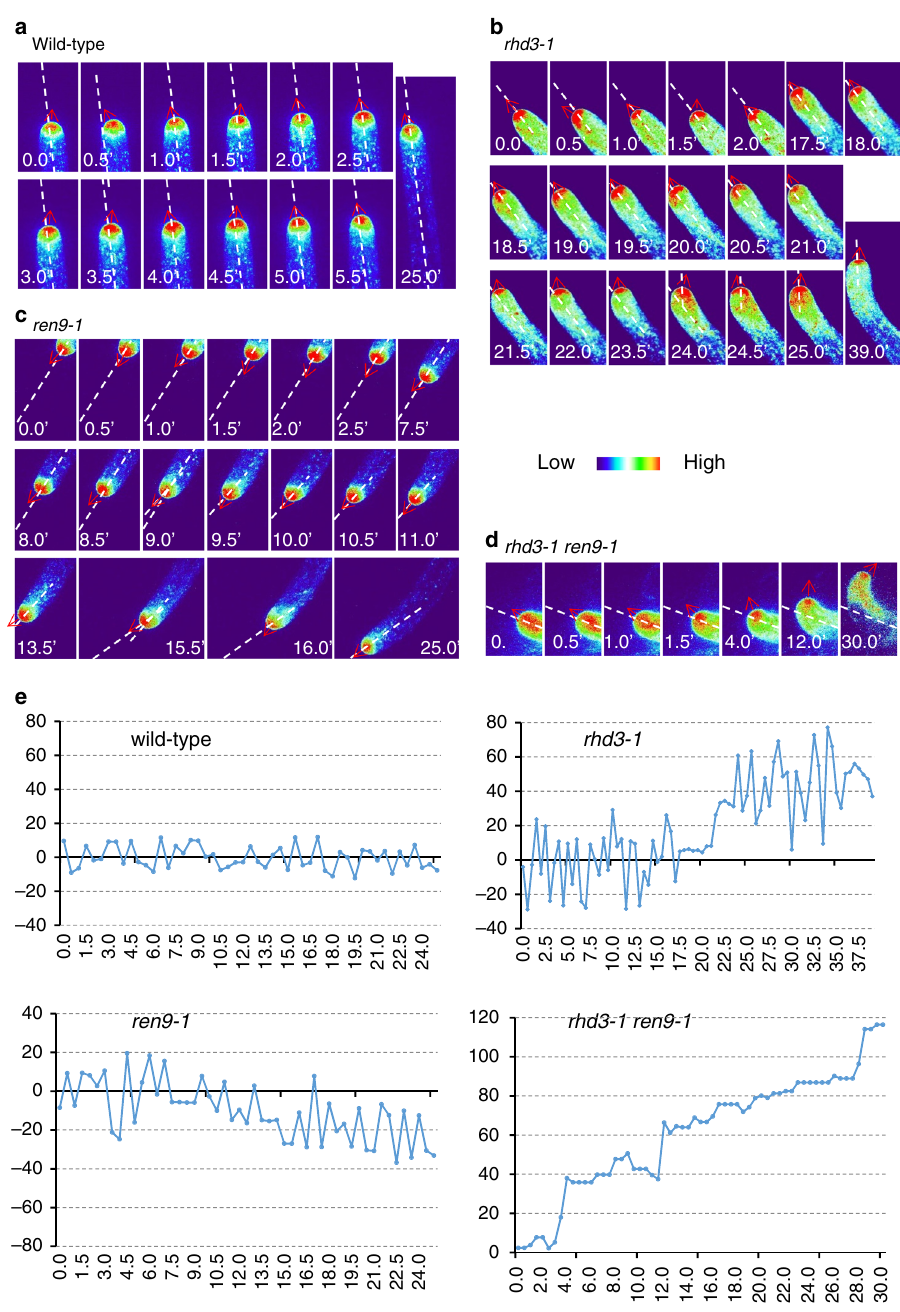
Fig. 2 Targeting of YFP-RAB-A2a at the tips of growing root hairs. a – d Heatmap of the targeting of YFP-RAB-A2a in a root hair of wild-type ( a ), rhd3-1 ( b ), ren9-1 ( c ), and rhd3-1 ren9-1 ( d ). e Quanti fi cation of swings of YFP-RAB-A2a targeting related to the previous growth direction (marked by white dashed lines in a – d ). YFP-RAB-A2a signals are shown in the heatmap format. The color code illustrates the signal intensity. Red arrows indicate the targeting direction of YFP-RAB-A2a at the tips. White dashed lines present the previous direction of root-hair growth. The experiment was independently repeated six times. In wild-type, there were rapid swings of YFP-RAB-A2a ( a , e ); in rhd3-1 , rapid swings were suspected from 18 ′ to 39 ′ ( b , e ) at which the root hair started to bend. In ren9-1 , there were also suspensions of rapid swings at 7.5 ′ -9 ′ and 11 ′ -15.5 ′ ( c , e ). In rhd3-1 ren9-1 , there was no swing at all; YFP- RAB-A2a was targeted toward the bending direction ( d , e ). The scale bars = 10 µ